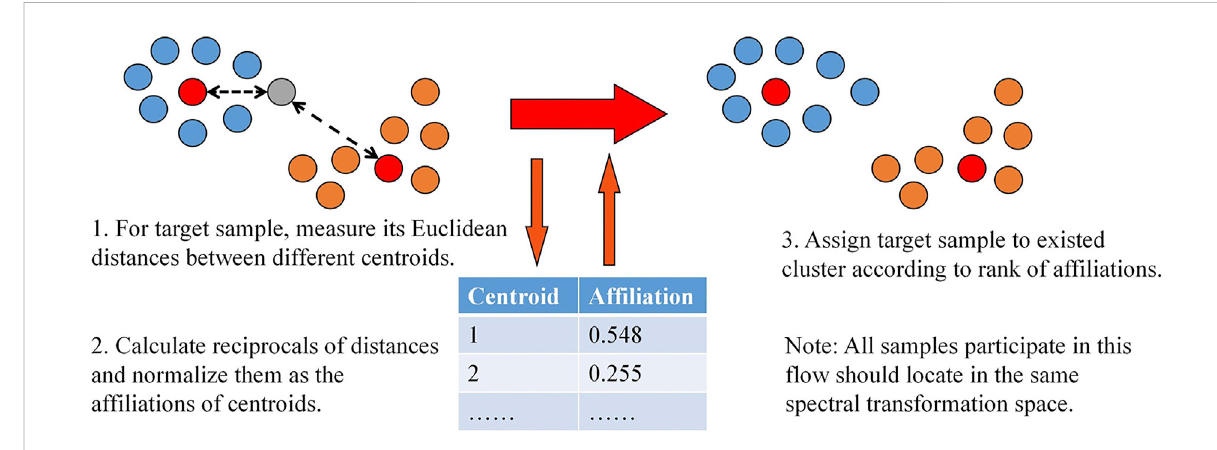
FIGURE 3 Flow of proposed concise labeling method for new samples.